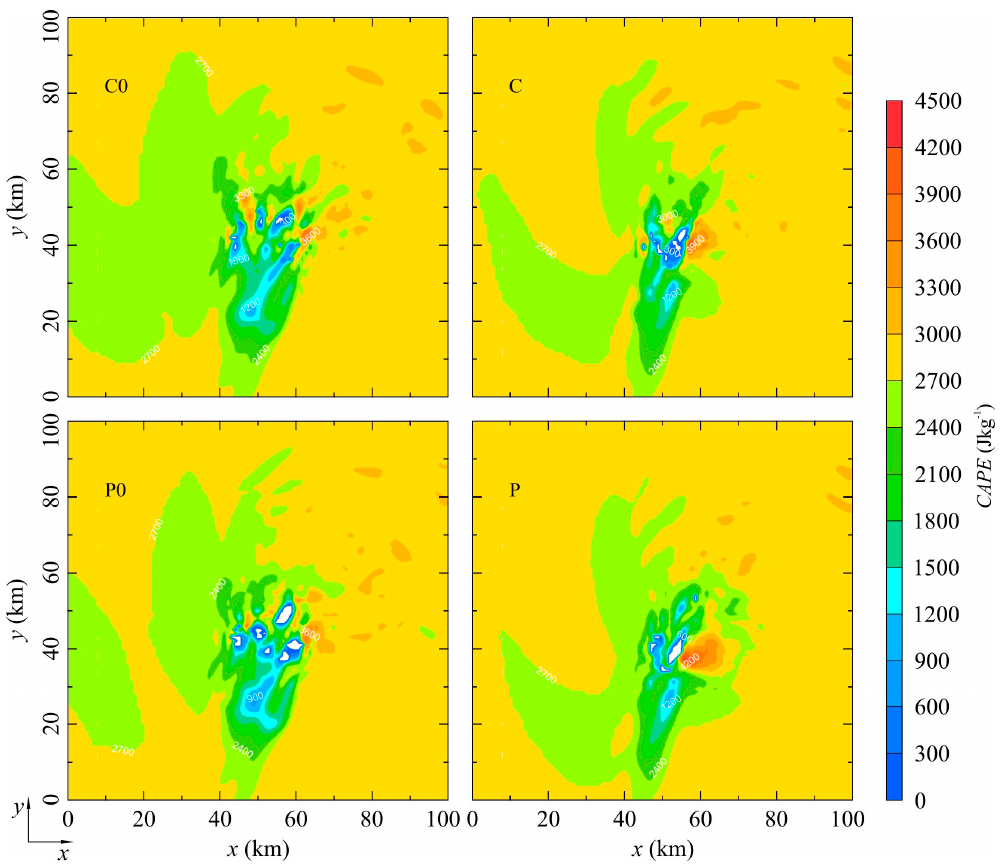
Figure 14. As in Figure 3, but for the maximum number concentration (m − 3 ) of ( a ) rain and ( b ) hail.